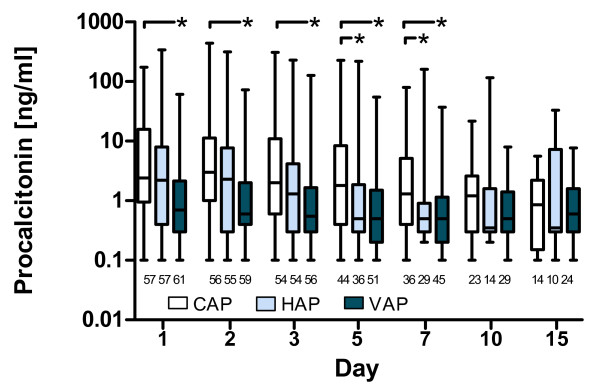
Time course of procalcitonin levels in patients with pneumonia. Box plot representing the time course of PCT over the two weeks following study inclusion in patients with CAP, HAP, and VAP. * P < 0.05 compared with CAP.